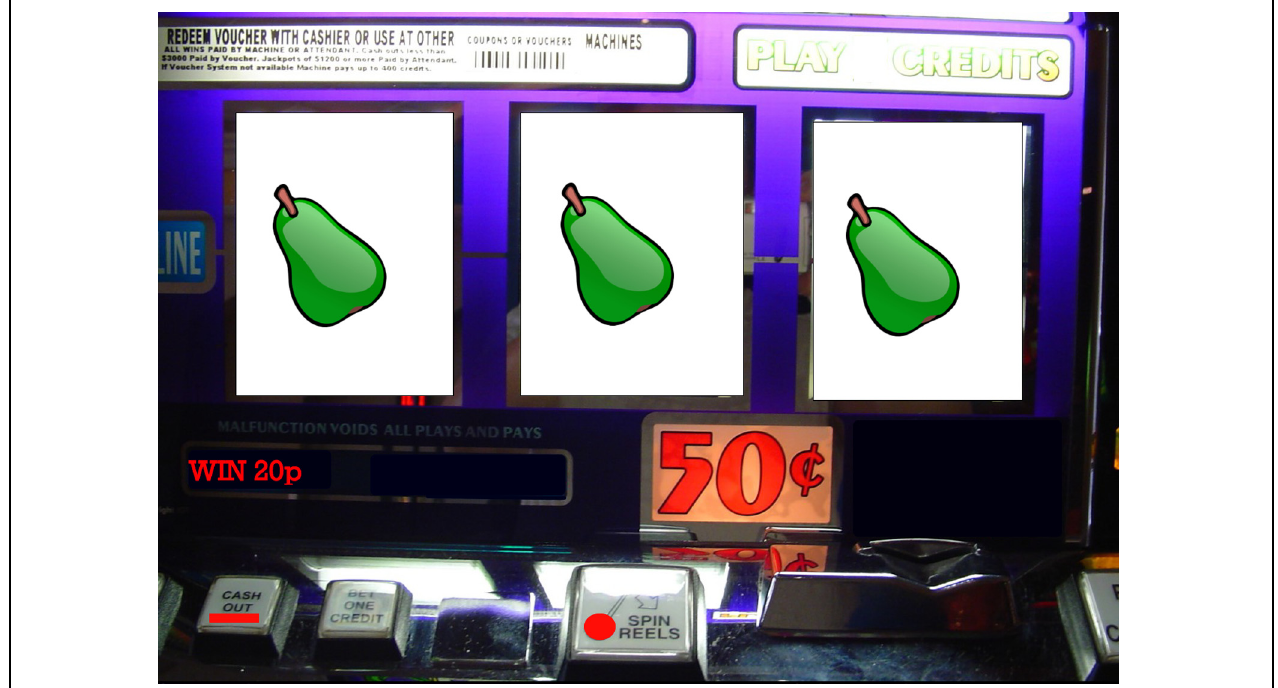
FIGURE 1 | Screenshot of the slot machine display participants were given during the partial reinforcement